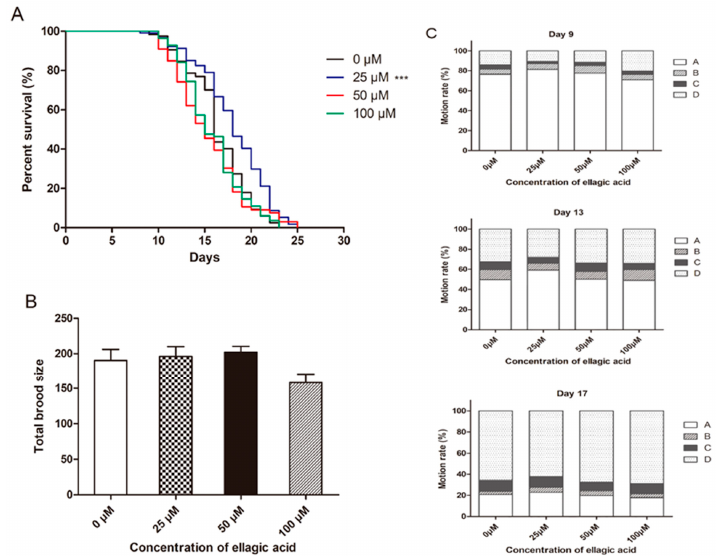
Figure 5. The effects of ellagic acid on the health indexes of the wild-type nematodes N 2 . L4-stage worms were transferred onto NGM agar plates containing different concentrations of ellagic acid (0, 25, 50, and 100 μ M). ( A ) The survival analysis of worms at different concentrations of ellagic acid, n > 100. ( B ) Total brood size showed the total number of eggs laid by each worm, n > 10. Each column represents the mean ± SD. ( C ) The motility of the nematodes was observed respectively on days 9, 13, and 17. The graph represents the ratio of different movement states in the nematodes treated with or without ellagic acid, n > 100. p < 0.001 (***).